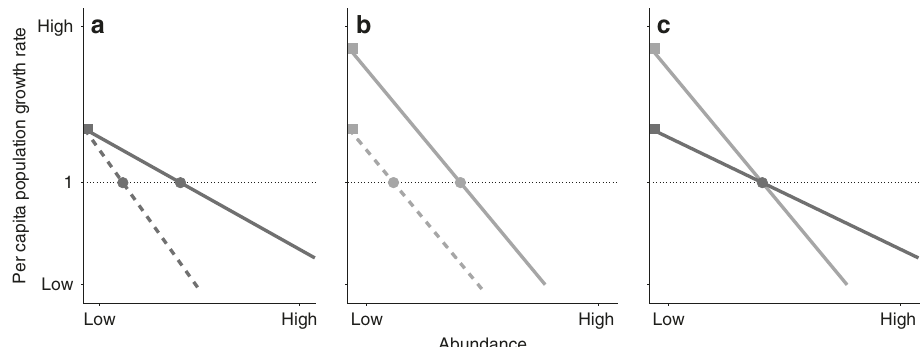
Fig. 1 A framework to compare mechanisms that shape species abundance. Lines represent species; we assume here that all species have per capita growth rates (calculated as the population size in time t + 1 divided by the population size in time t ) that decrease with abundance. A species ’ growth rate when rare (GRWR) is indicated by a species ’ y -intercept (squares). Intraspeci fi c negative density-dependence (NDD) is indicated by the slope of a species ’ line. We expect dynamics to shift a species abundance toward the case where per capita population growth rate is one (the circles, which we term predicted average abundance). a Predicted average abundance decreases with NDD; the solid species is more abundant than the dashed species due to weaker NDD for the solid species. b Predicted average abundance increases with GRWR; the solid species is more abundant than the dashed species due to a higher GRWR of the solid species. c Two species may be equally abundant but for different reasons; the dark species has weaker NDD whereas the light species has a higher GRWR. The light species can recovery more quickly when rare and should therefore be more stable over time. Note that relationships are not necessarily linear, but are depicted as such for visual